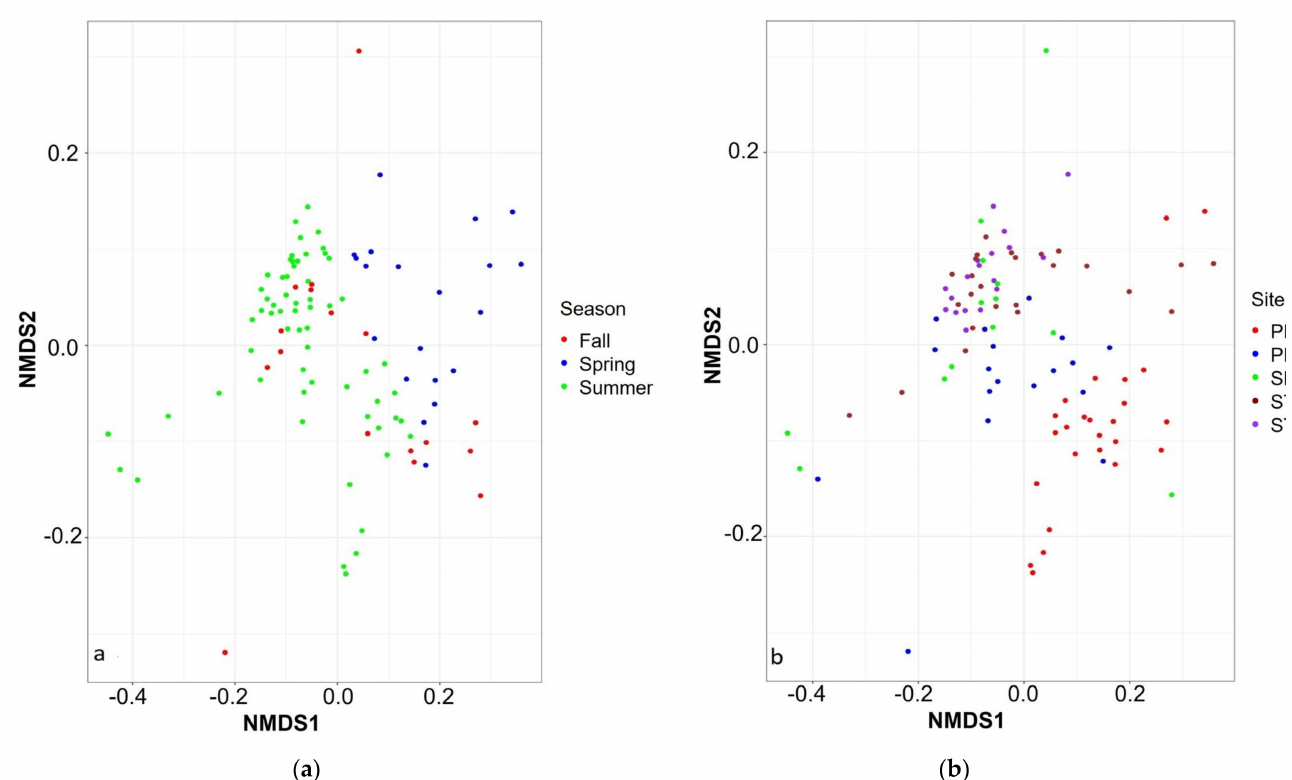
Figure 8. Jensen–Shannon divergence based on ( a ) seasons and ( b ) sampling